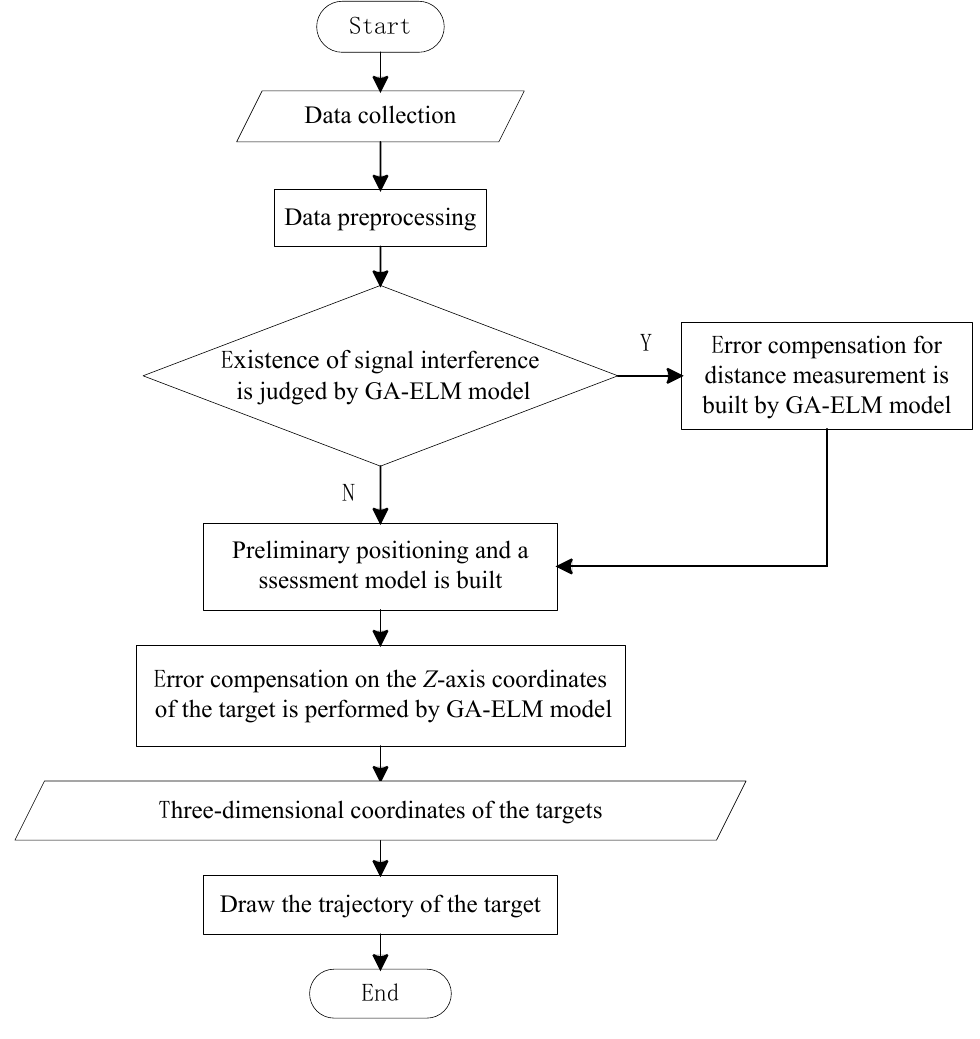
Figure 2. Workflow chart of the overall